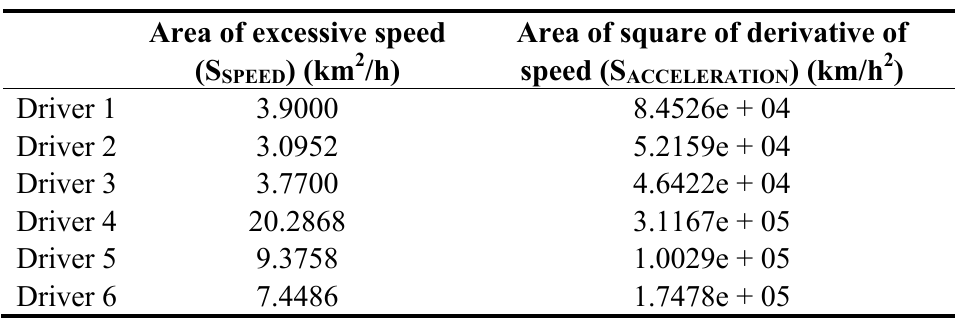
Table 1. Results.